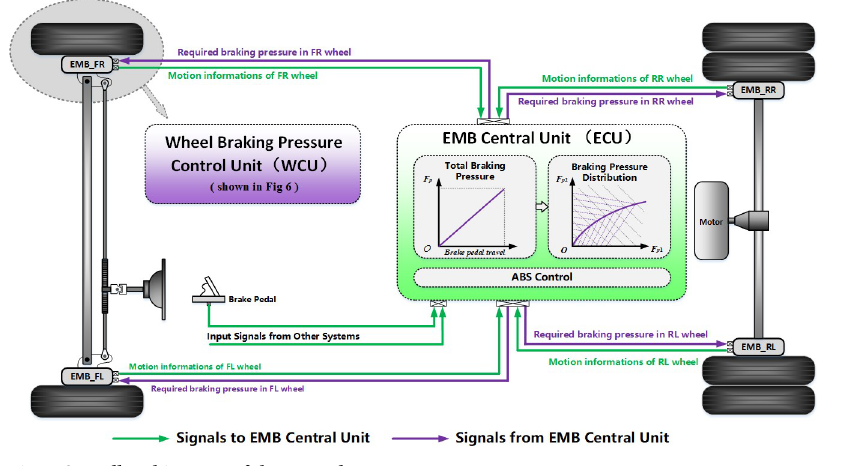
Fig 4. Overall architecture of the control